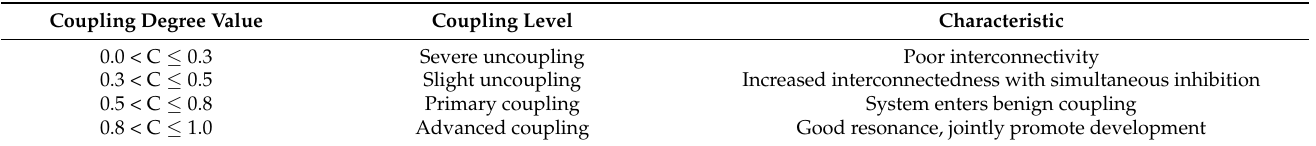
Table 2. The classification of coupling degree.